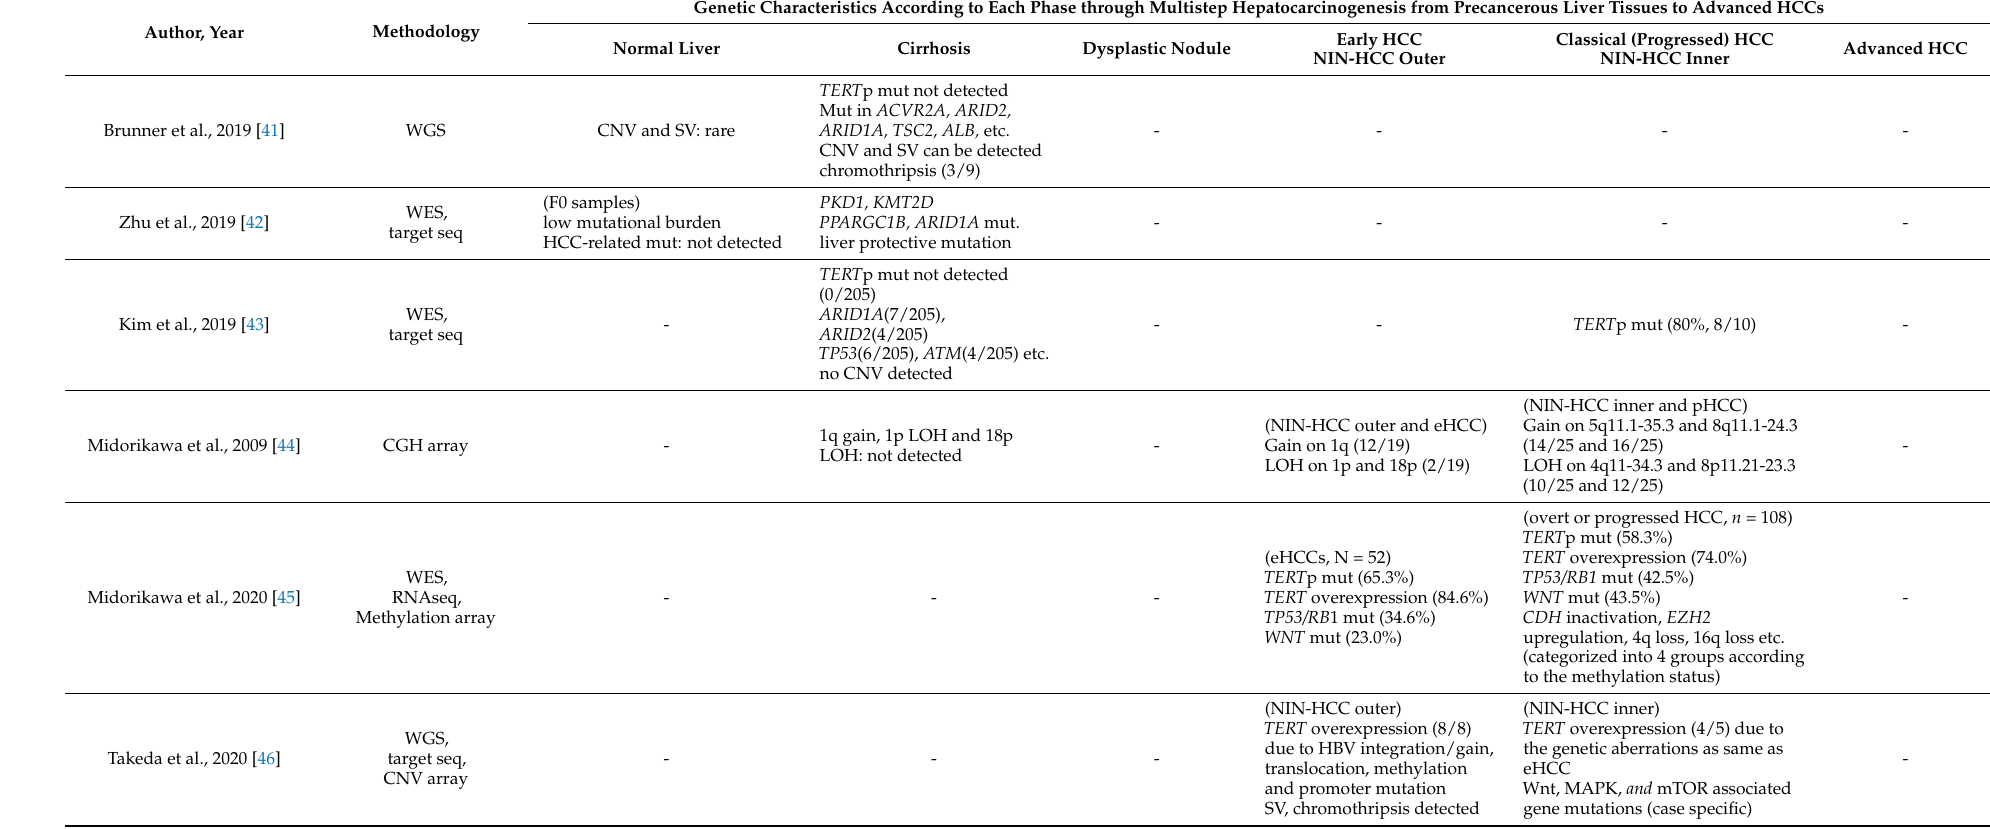
Table 2. Summary of the multistep accumulation of genomic and transcriptomic aberrations during